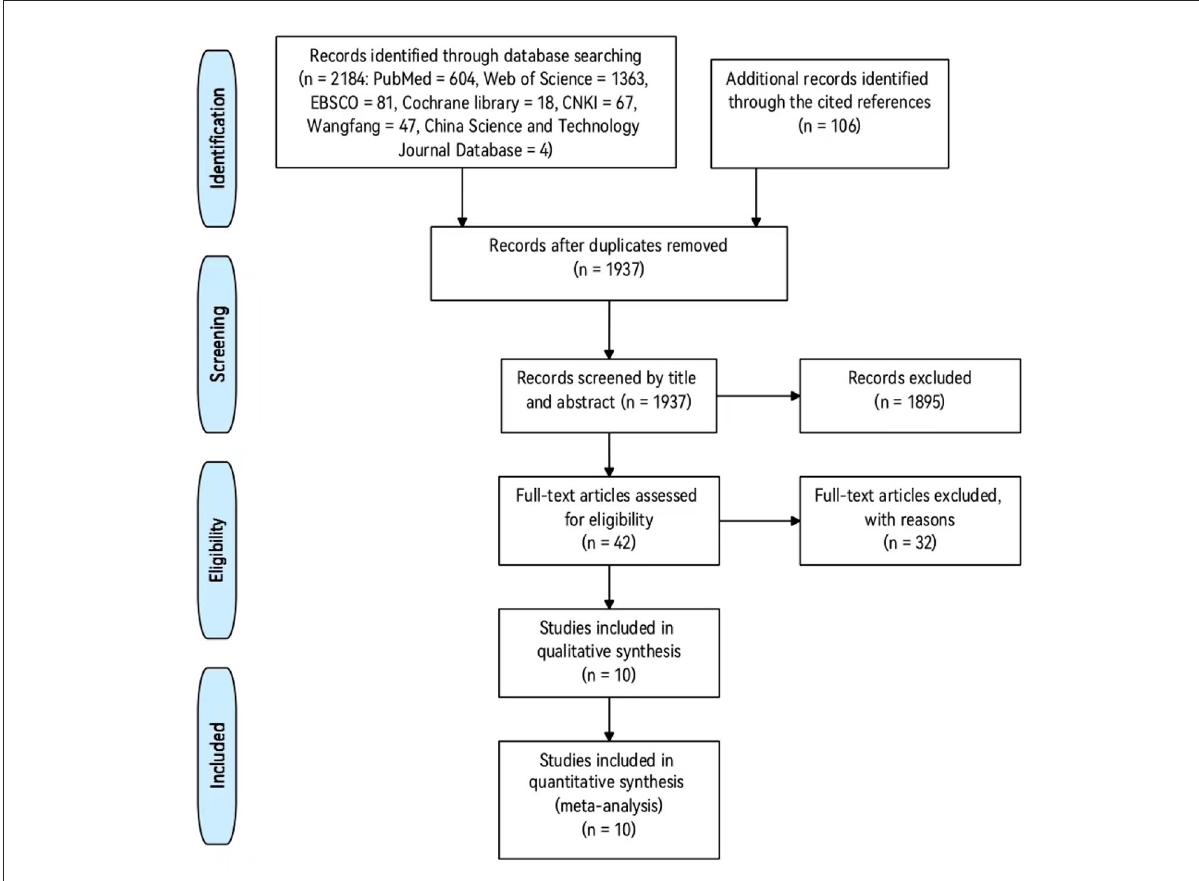
FIGURE1 The flowchart of search